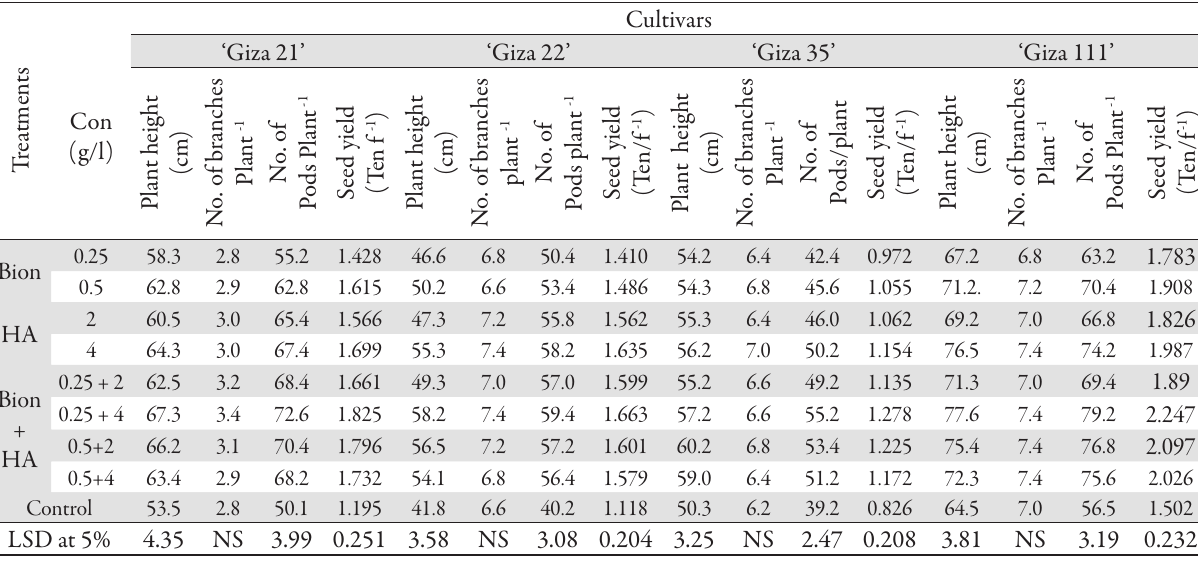
Tab. 5. Effect of BTH and HA on growth parameters of the four soybean cultivars under field conditions on New Valley governorate at summer season 2010